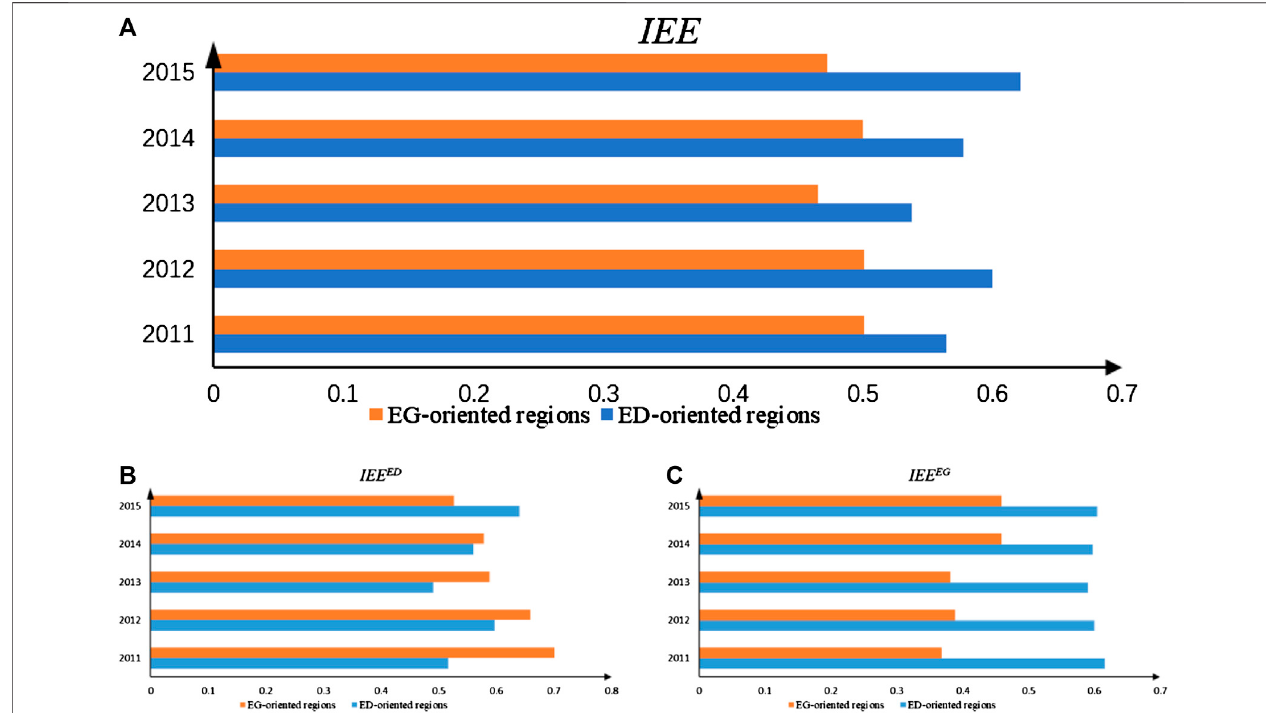
FIGURE 4 | The comparison of IEE, IEE ED and IEE EG in different regions.